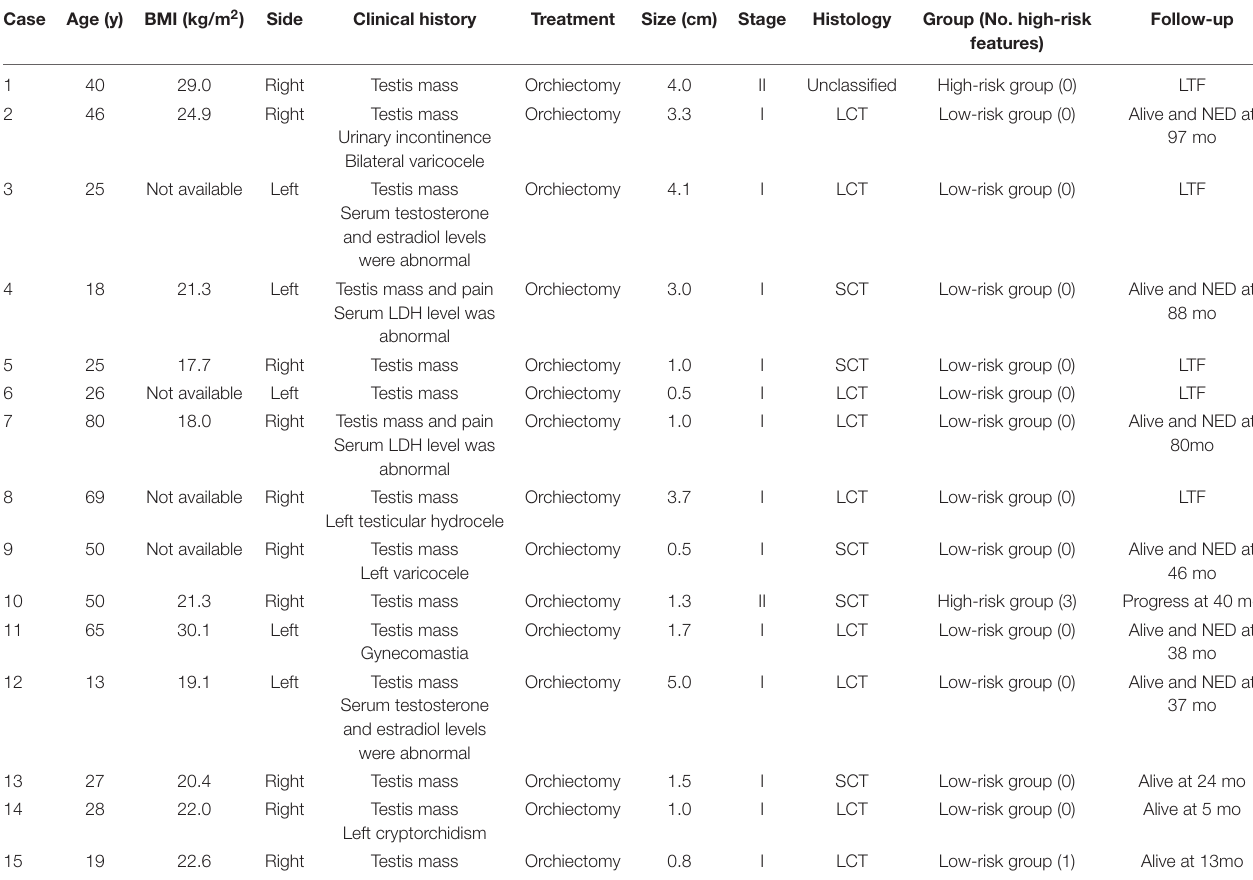
TABLE 1 | Clinical features and treatment in 15 patients with TSCSTs. Case Age (y) BMI (kg/m 2 )